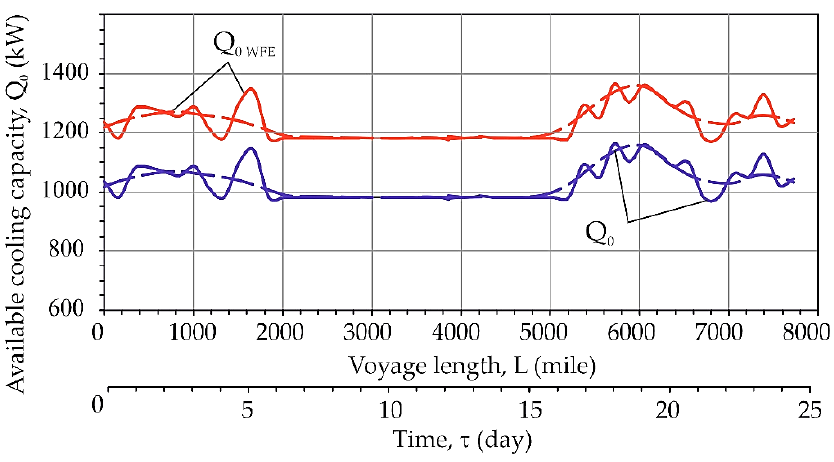
Figure 10. The available cooling capacities of ECh: Q 0 — fuel oil; Q 0.WFE — WFE.